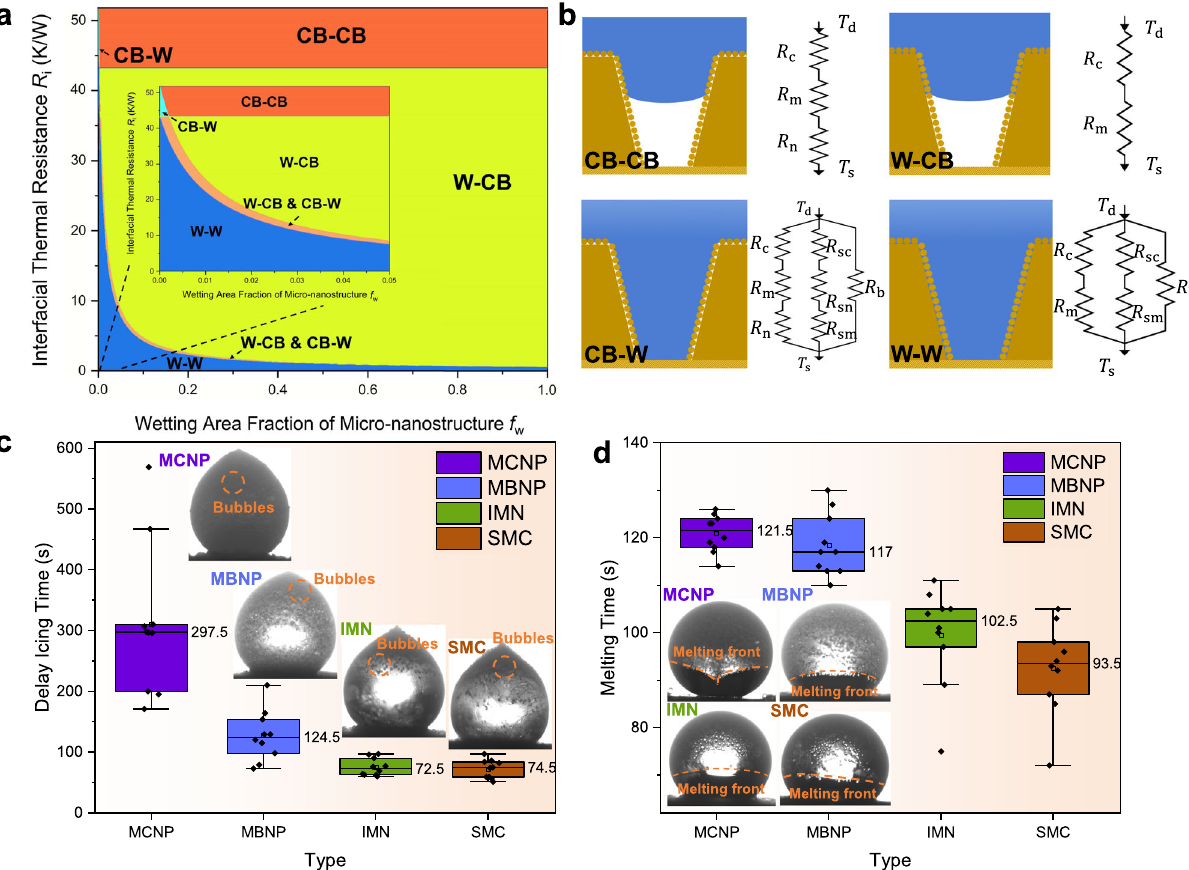
Fig. 6 Analysis of the interfacial thermal resistances R i in different wetting modes and experimental results for icing delay time and melting delay time on the four surfaces. a Phase diagram of interfacial thermal resistances R i in different wetting modes. The local magni fi ed diagram is inserted in the center, and different wetting modes are marked. b Schematic showing different wetting modes and their equivalent thermal resistances. Droplet temperature ( T d ), substrate temperature ( T s ) and different equivalent thermal resistances are marked. c Median icing delay time on the four surfaces. The icing delay time is recorded from the beginning of the icing process (15 °C) to the recalescence. The side views of ice droplets on the four surfaces are presented. The bubbles of ice droplets are also marked with orange dashed boxes. d Median melting delay time on the four surfaces. The melting delay time is recorded from 0 °C to the end of melting. The side views of ice droplets during melting processes are also presented. Melting fronts are marked with orange dashed lines. For each type of surface, 10 repeated experiments are conducted to guarantee the accuracy of the